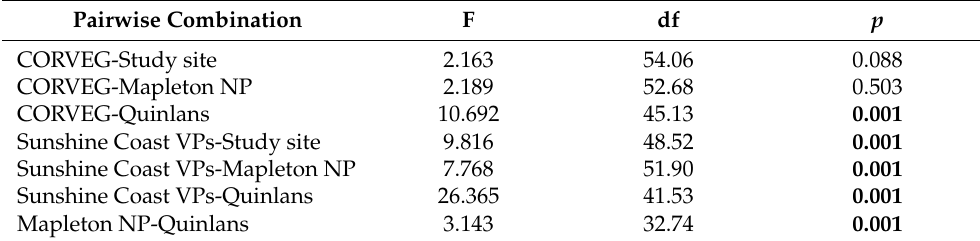
Table 11. Differences in the maximum heights between the CORVEG and Sunshine Coast intra ‐ subregional study sites; significant p ‐ values (Welch’s t ‐ test) are shown in bold.